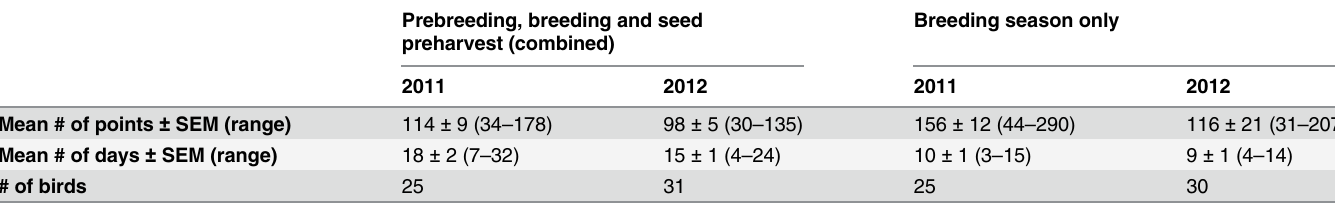
Table 2. The number of points recorded for and the number of separate days I followed individual Clark ’ s nutcrackers.